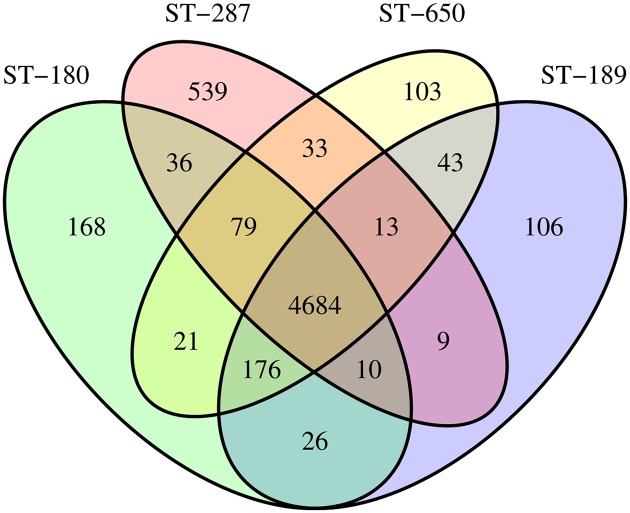
Venn diagram showing the number of core and ST-specific ortholog families.ST, multilocus sequence type.